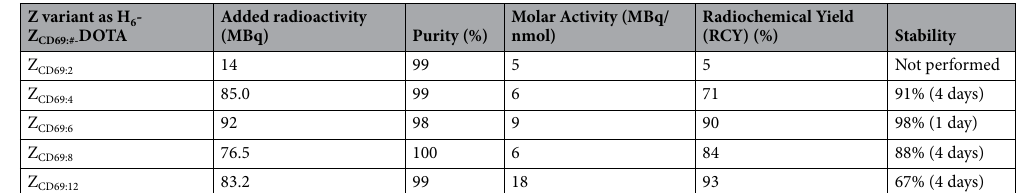
Table 3. Results of radiolabeling tested DOTA-Z CD69:# variants with indium-111.